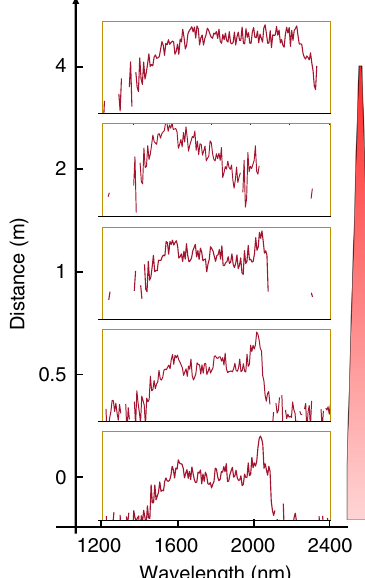
Fig. 5 Experimentally observed spectra associated with multimode solitons along the tapered multimode fi ber. The NIR spectrum measured along the taper (right) when excited with 100 fs pulses at 1550 nm having a peak power of 750 kW. In the lowest panel, recorded right before the start of the tapered section, the multimode soliton spectrum resides in the long wavelength edge — around 2000 nm. However, after 0.5 m of propagation, the energy is transferred towards shorter wavelengths. After 2 m of propagation, most of the energy is found to be below 1600 nm. Finally, at the end of the taper, the soliton energy is uniformly distributed over a wide spectral window extending from 1500 to 2300 nm. The height of each panel is scaled at 20 dB. The tapered multimode fi ber is depicted on the right side, where the darker red color represents an increase in the light intensity in the fi ber due to a decrease in core